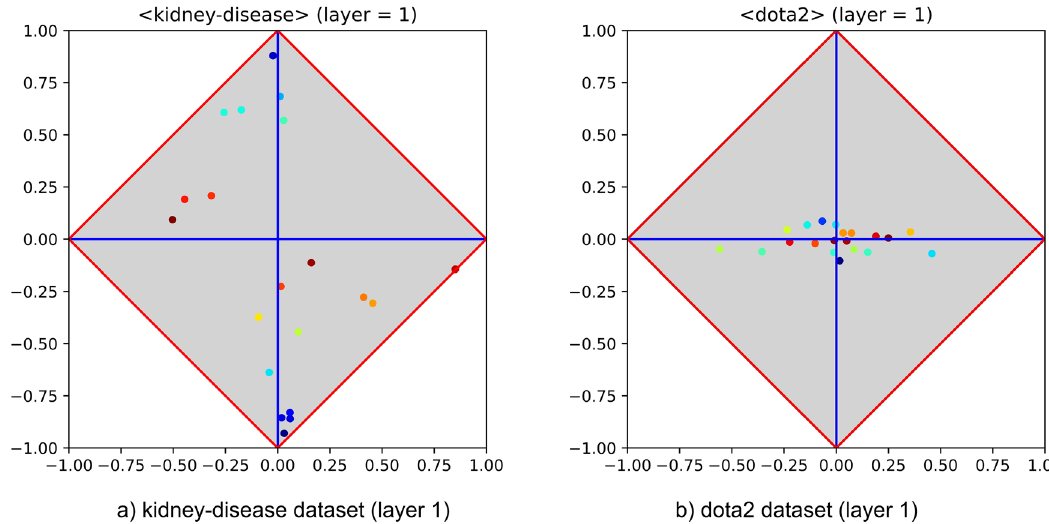
Figure 3. Hidden layer class signatures of MLPs trained on kidney-disease and on dota2 (left- and right-hand side). The diagrams highlight that the neuron outputs obey to very different patterns (i.e., success and failure, respectively).